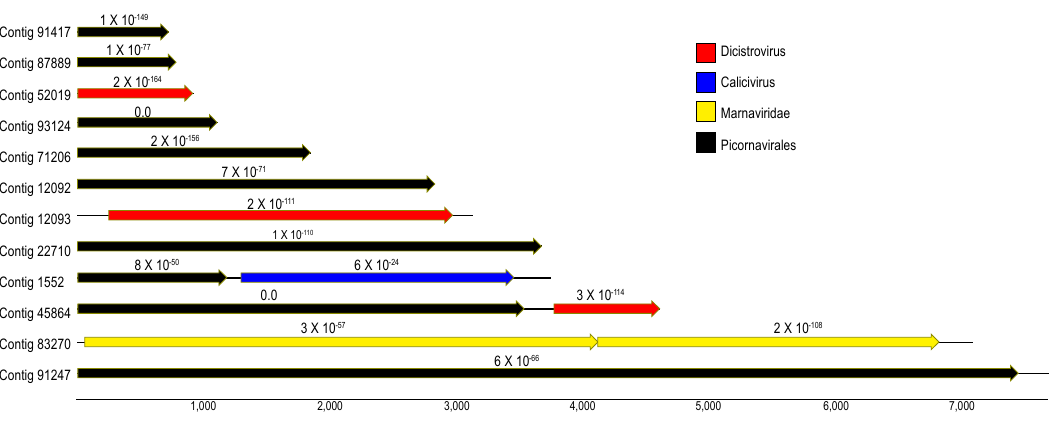
Figure 3. Maps of contiguous sequences matching Picornavirales recovered in this survey of Pisaster ochraceus . Contigs were annotated based on BLASTx ( e -value < 1 × 10 − 20 ) against the non-redundant database at NCBI. The color of arrows (open reading frames) indicates the taxonomic identity of their best matches. Numbers above the ORFs indicate the e -value of BLAST results. The total contig lengths are indicated by solid lines running through and between ORFs.